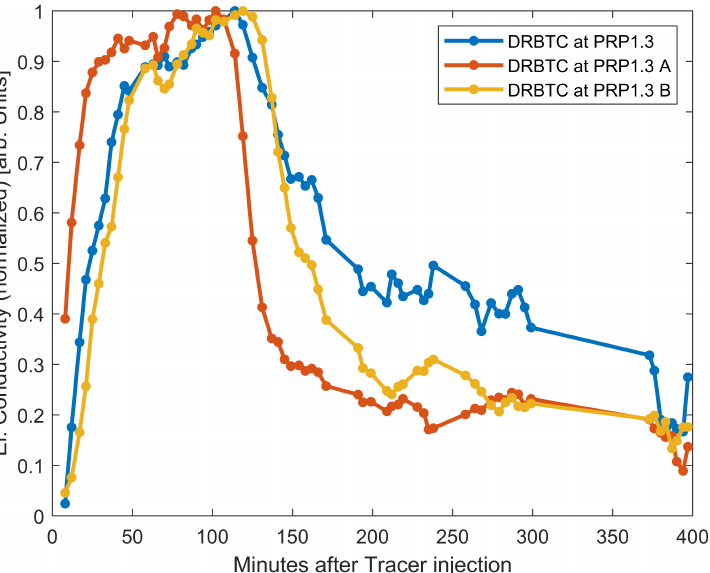
Figure 9. DRBTCs for the two inferred flow paths A and B towards PRP1.3, along with the PRP1.3